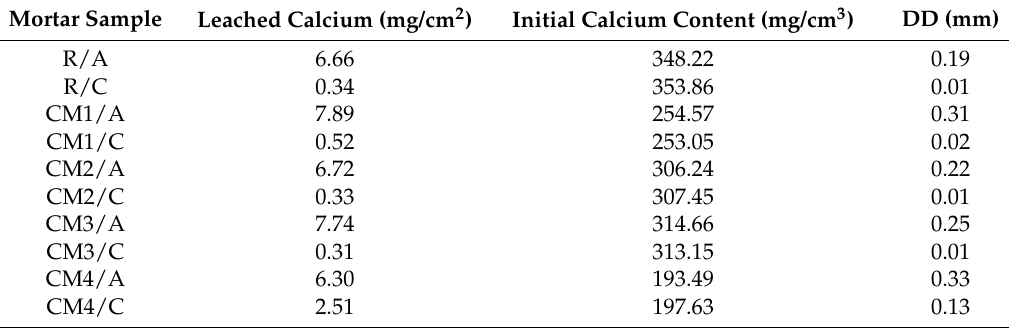
Table 2. Damaged depths of mortars over the 90-day